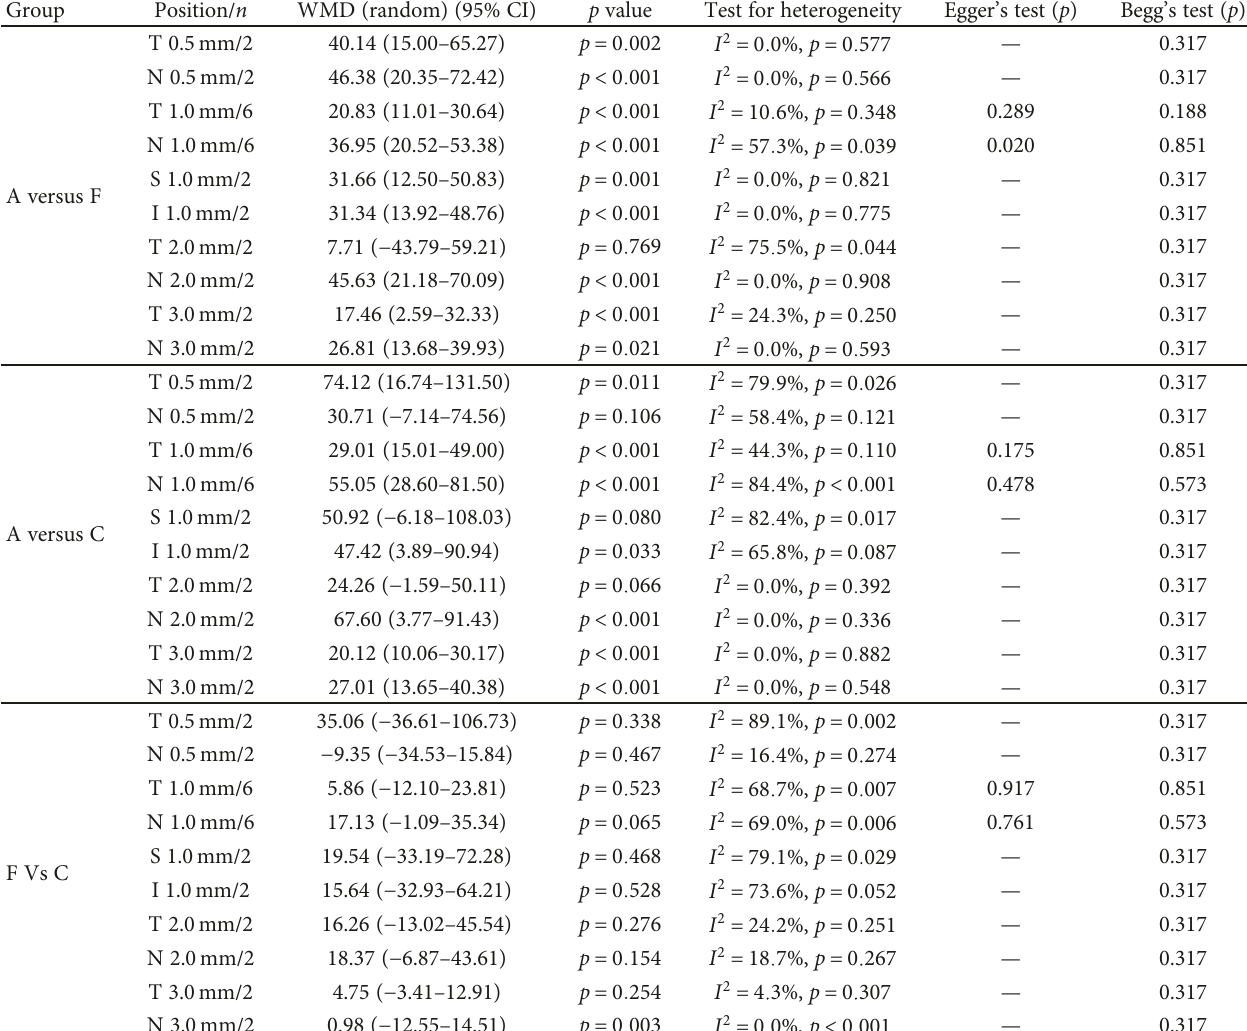
Table 3: Pooled estimates of all studies comparing other positions in the amblyopic eye with the fellow and normal eyes. Group Position/ n WMD (random) (95% CI) p value Test for heterogeneity Egger ’ s test ( p